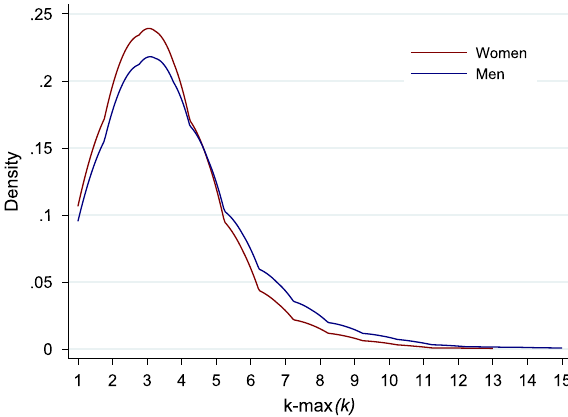
Fig. 2 Probability density distribution of k ‑max by